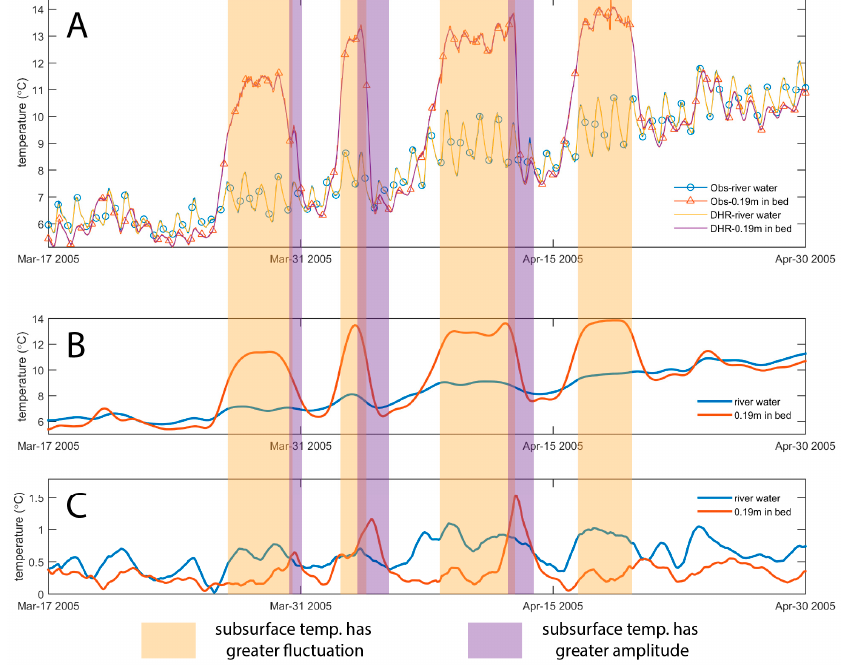
Figure 6. Demonstration of the data filtering procedure based on Spring 9 temperature data.